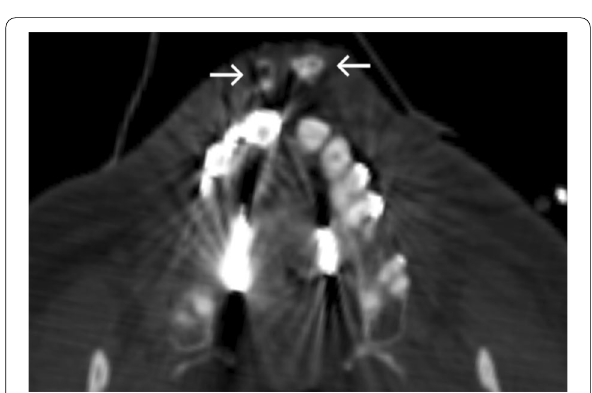
Fig. 4 Broken teeth. Axial CT image showing multiple dislocated hyperdense objects in the upper lip